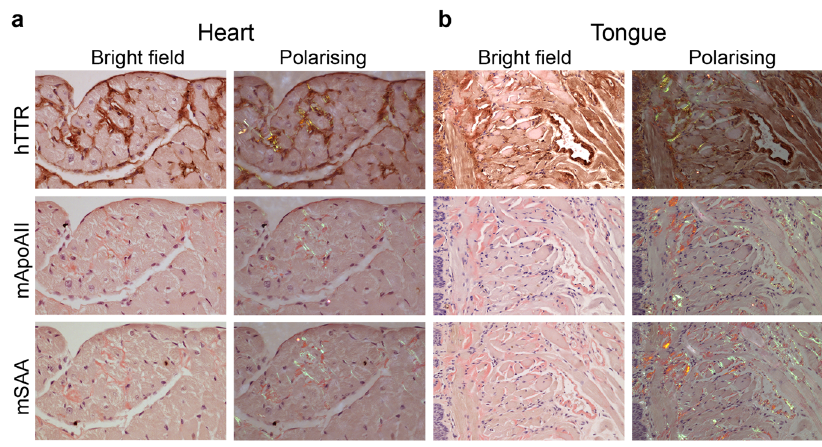
Fig. 3 Immunohistochemical demonstration of ATTR amyloid in the transgenic model. To determine the amyloid type, heart ( a ) and tongue ( b ) were stained with anti-human TTR, anti-mouse apoAII or anti-mouse SAA antisera, as indicated, followed by alcoholic alkaline Congo red. Bright fi eld images show the immunohistochemical signal (brown), and faint red Congo red stained amyloid in a representative amyloidotic line N4 mouse ( n = 15). The amyloid deposits exhibited the characteristic red-green birefringence when viewed by polarising microscopy. The coincidence of TTR signal and amyloid, together with the absence of apoAII and SAA signal, demonstrates that the amyloid is of ATTR type. In places, the intense anti-TTR staining obscured the Congo red staining, the extent of which is clearly visible in the closely adjacent sections stained for apoAII and SAA. Scale bar, 100 µ m ( a ) and 200 µ m ( b ). hTTR human TTR, mApoAII mouse apolipoprotein A2, mSAA mouse serum amyloid A